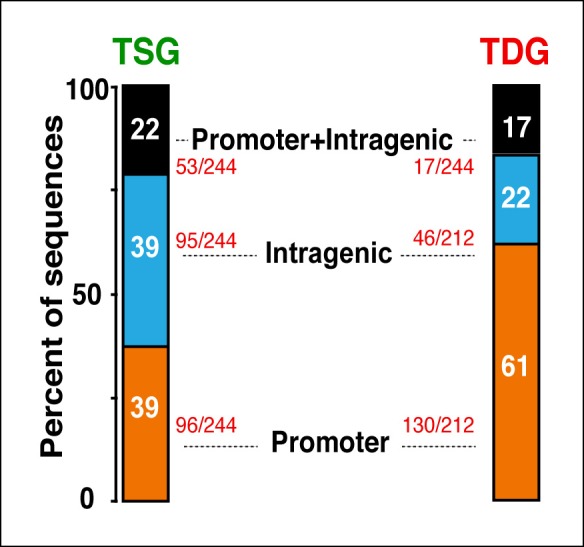
Distribution of Tat occupancy at promoter and/or intragenic domains in TSG and TDG.The percentage of sequences from the total is indicated. TDG, Tat downregulated genes; TSG, Tat stimulated genes.